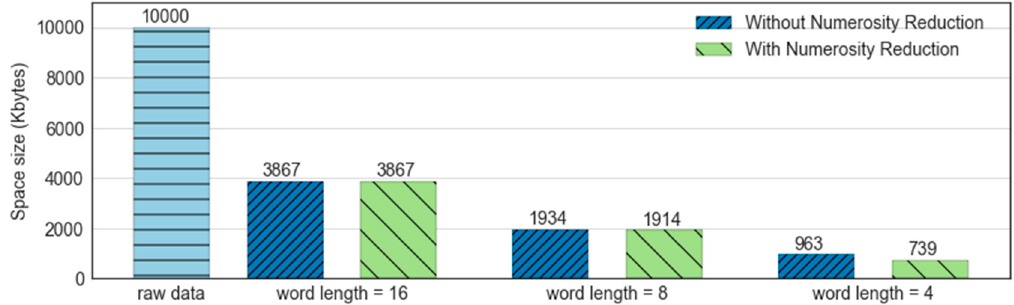
Figure 13. Comparison of the cost of memory space required for the processing of time series.